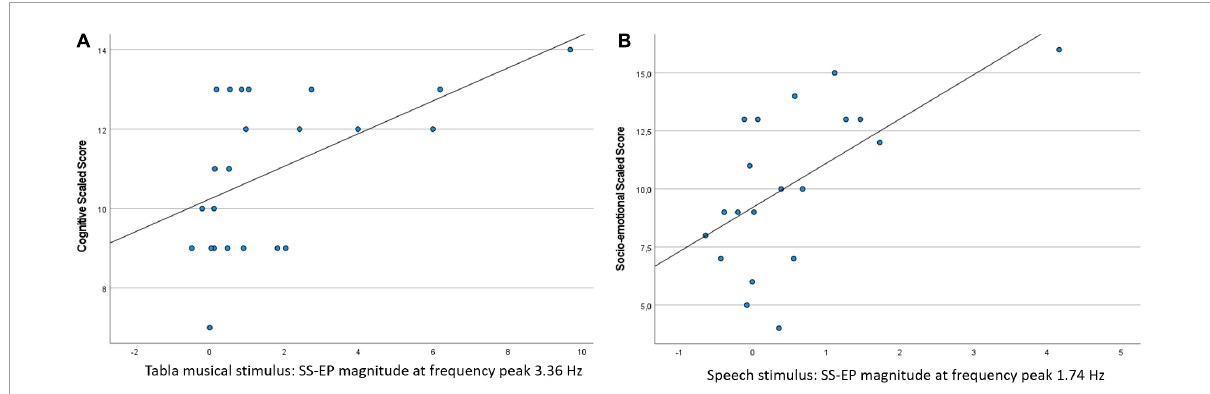
FIGURE4 Scatterplots of the significant correlations between SS-EP magnitude in the neural entrainment task and concurrent standardized measures of development: (A) SS-EP magnitude in the Tabla musical stimulus (at frequency peak 3.36 Hz) is plotted against the cognitive scaled score; (B) SS-EP magnitude in the Speech stimulus (at frequency peak 1.74 Hz) is plotted against the socio-emotional scaled